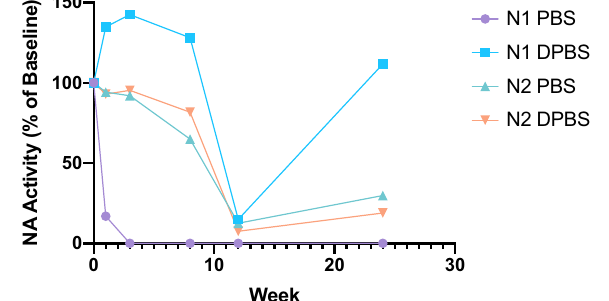
Fig. 3 NA activity of N1 and N2 stored in PBS or DPBS at room temperature for 24 weeks. NA activity of N1 and N2 in PBS or DPBS at room temperature was measured using MU-NANA assay in triplicate at weeks 0, 3, 8, 12, and 24 using week 0 as a baseline. Points represent individual